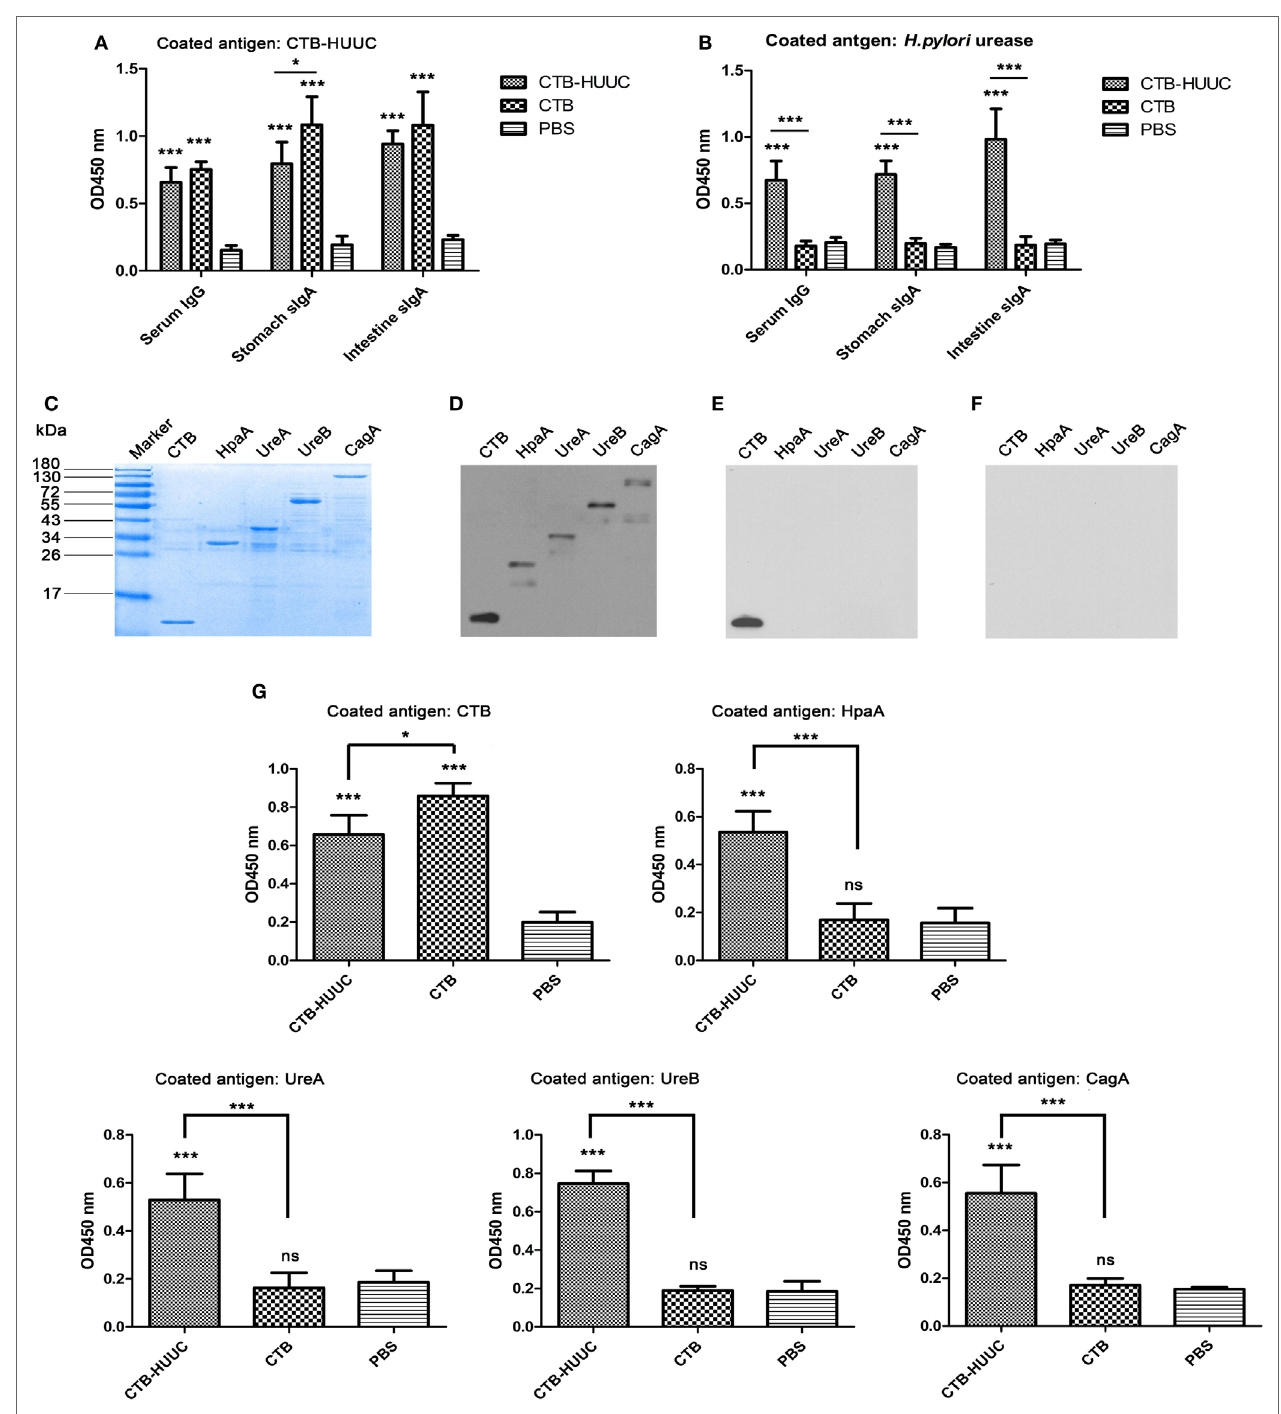
FigUre 2 | Specific IgG or IgA levels in immunized mice serum, gastric mucus, and intestinal mucus. Serum, stomach, and intestine tissue samples were collected from mice immunized with cholera toxin B subunit (CTB)-HUUC, CTB, or PBS. The levels of serum IgG, and stomach and intestine mucosal IgA against CTB-HUUC (a) or Helicobacter pylori urease (B) were determined by ELISA. *** p < 0.001, compared with the PBS group, * p < 0.05, compared between the CTB-HUUC and CTB groups. (c) Visualization of the adjuvant CTB and the H. pylori antigens [ H. pylori adhesion A subunit (HpaA), urease A subunit (UreA), urease B subunit (UreB), and cytotoxin-associated antigen (CagA)] purified from Escherichia coli BL21(DE3) transformed with pET28a( + )/ ctB , pSUMO/ hpaA , pSUMO/ ureA , pET28a( + )/ ureB , or pET28a( + )/ cagA . These purified peptides were resolved in 12% SDS-PAGE gel and stained with Coomassie Blue. The resolved peptides in 12% SDS-PAGE gels were also probed by antiserum collected from mice immunized with CTB-HUUC (D) , CTB (e) , or PBS (F) . (g) The specificity of serum from mice immunized with CTB-HUUC was analyzed by ELISA. *** p < 0.001 and * p < 0.05 compared with the PBS group or between the CTB-HUUC and the CTB